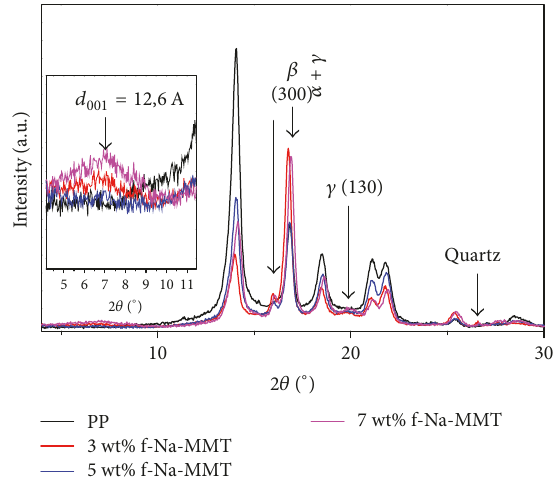
Figure 5: WAXS patterns of 3, 5, and 7wt%/PP nanocomposites.